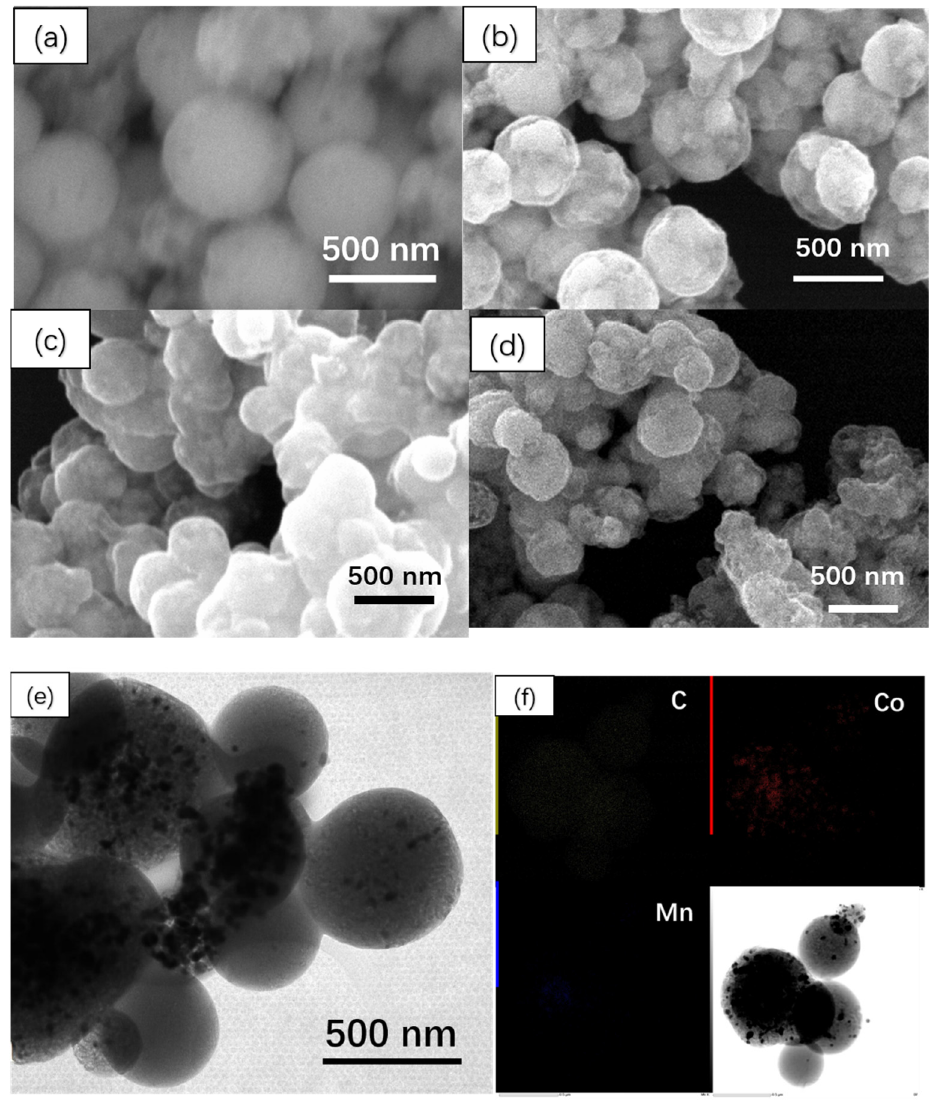
Figure 2. SEM images of MnCo 2 O 4 ( a ), MnO-Co@C-0.2 ( b ), MnO-Co@C-0.3 ( c ), and MnO-Co@C- 0.4 ( d ). TEM images of MnO-Co@C-0.3 ( e ), and elemental mapping distribution of MnO-Co@C-0.3 ( f ).